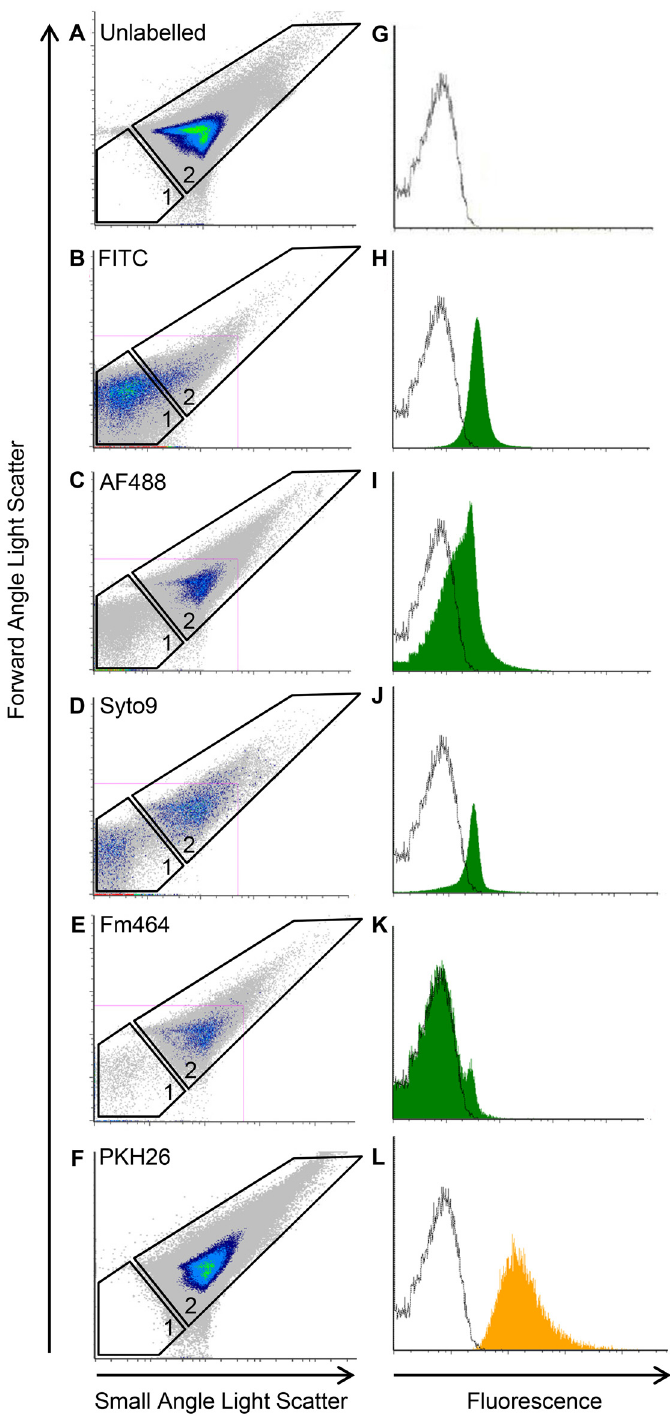
Fig 2. Enumeration of OMVs by high resolution flow cytometry. P . gingivalis purified OMVs unlabeled (A G) or labelled with either FITC (B H), AF488 (C I), Syto9 (D J), Fm464 (E K) or PHK-26 (F L) were analysed using an Apogee A50-Micro Flow Cytometer. Dye suitability was observed as determined by Forward/Small Angle Light Scatter (F/S-ALS) (A-F) and fluorescence (G-L).